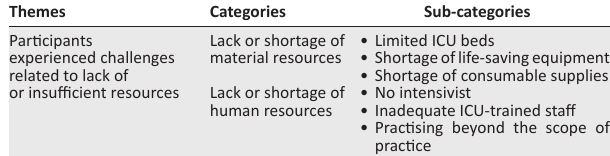
TABLE 1: Themes, categories and sub-categories of the